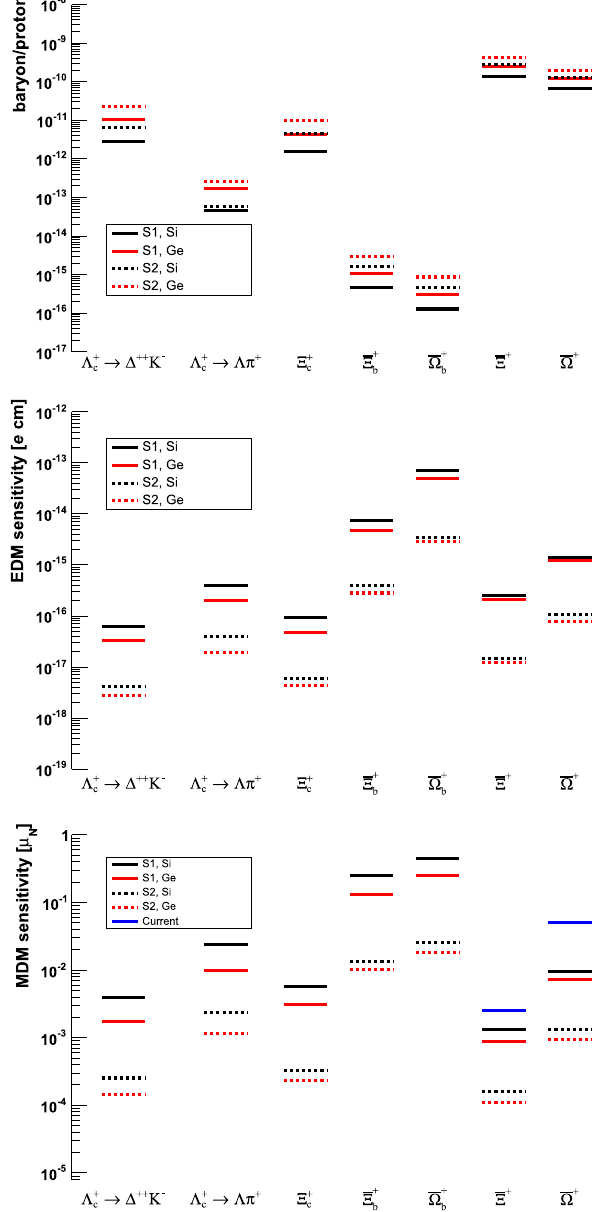
Fig. 13 (Top) Estimated yields of channeled and reconstructed signal baryons per incident proton on target, and (middle) EDM and (bottom) MDM sensitivities, for Si and Ge with crystal parameters optimized for S1 and S2 scenarios. A total of 10 15 and 10 17 protons on target have been considered for S1 and S2 respectively. For comparison pur- poses, the Λ + c case has been studied in the Δ ++ K − and Λπ + final states. Blue lines show the sensitivity of the current Ξ − and Ω − MDM